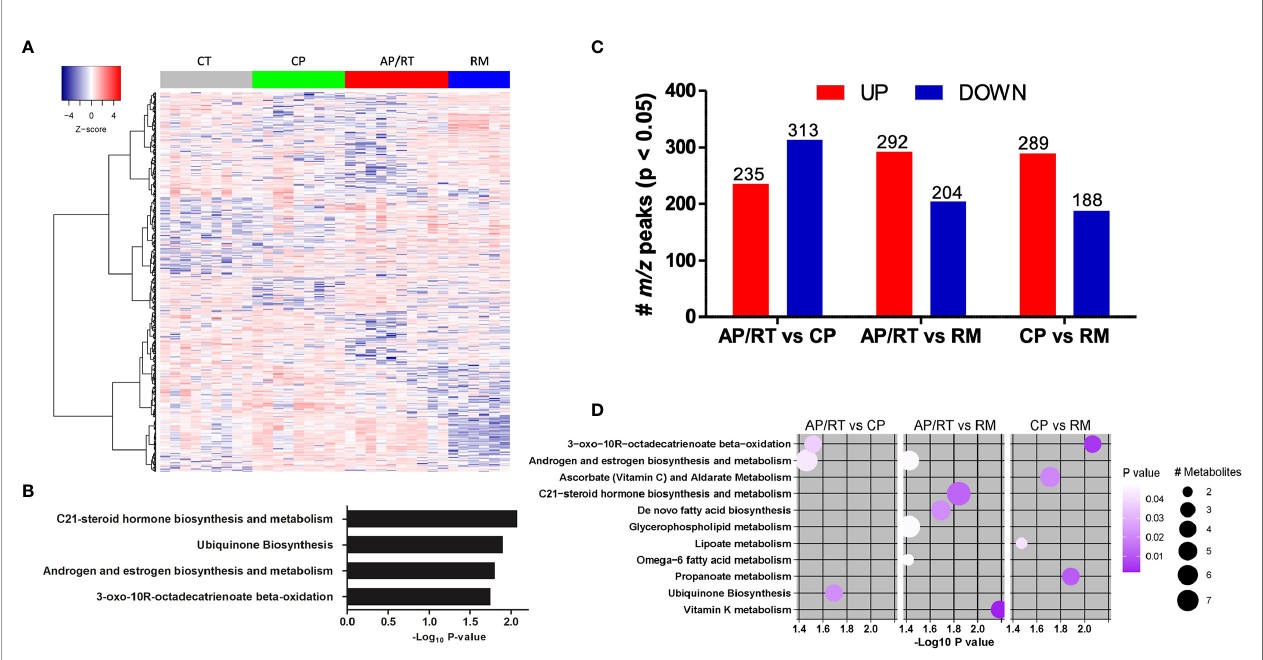
FIGURE 3 | Dynamic of the abundance of metabolite features associated with disease progression and response to TKI therapy. (A) One-way hierarchical clustering based on the intensity of highly signi fi cant metabolite features selected by ANOVA. (B) Metabolic pathways enriched by signi fi cant metabolite features. (C) Up- and downregulated abundant metabolites in patients in advanced (AP)/resistant (RT) vs. chronic phase (CP), AP/RT vs. remission post-TKI (RM), and CP vs. RM. (D) Metabolic pathways enriched by signi fi cant metabolite features. The circle size represents the number of differentially abundant metabolites, and the circle color means the degree of signi fi cance ( p -value magnitude) after comparison between the control and CML patient